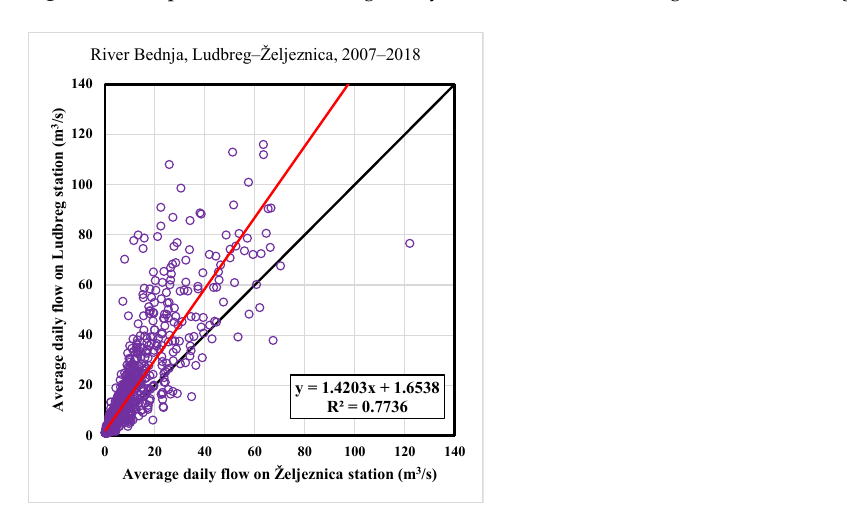
Figure 6. Comparison of the average daily flows for the measuring stations Ludbreg and Željeznica.